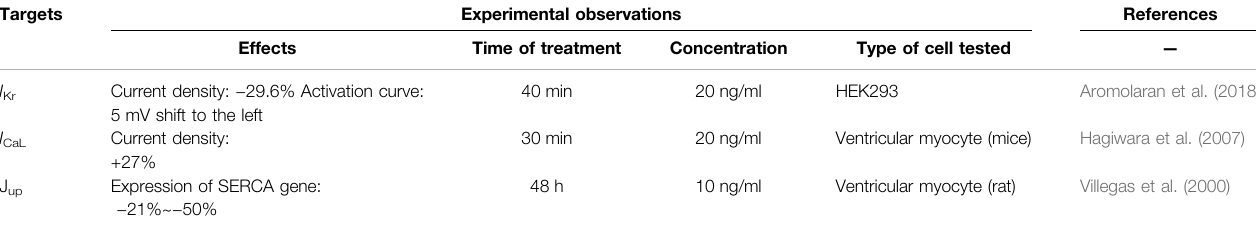
TABLE 2 | The effects of IL-6 on cellular targets. Targets